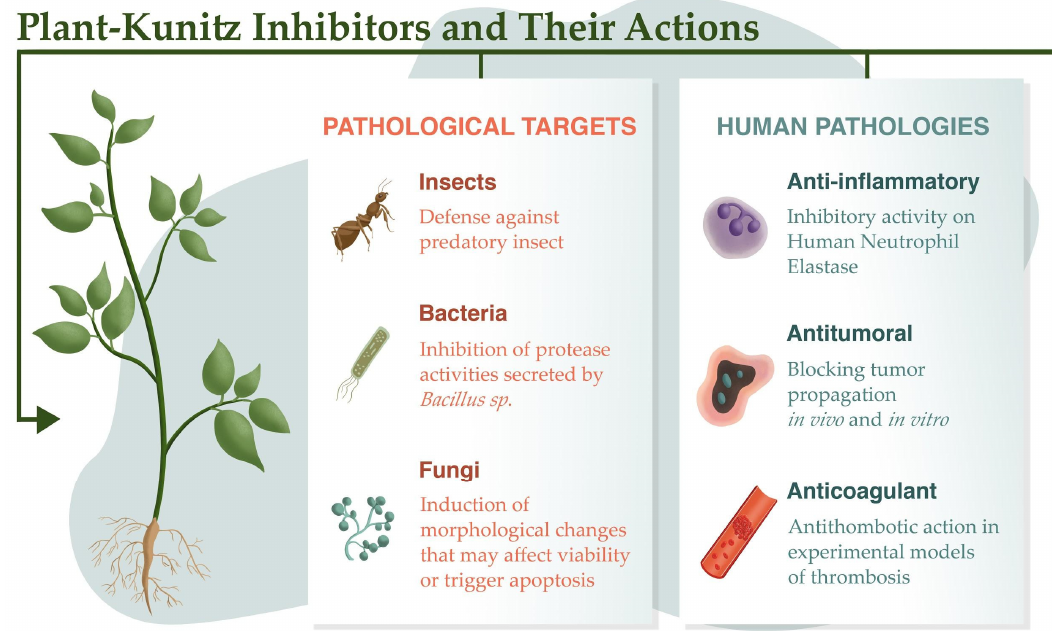
Figure 2. Uses of protease inhibitors as insecticides, and antibacterial and antifungal agents. The inhibitors are also active in mammal pathologies associated with inflammation, thrombosis, and